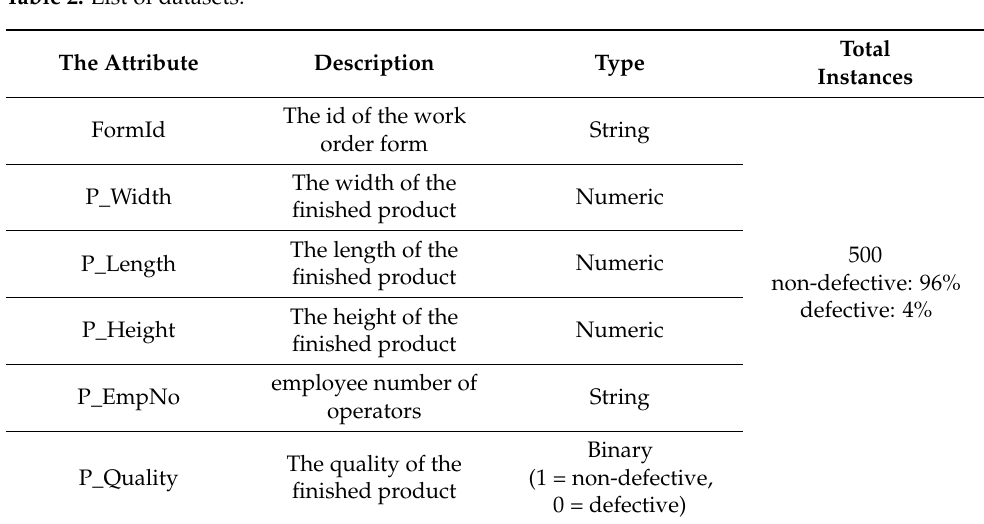
Table 2. List of datasets.